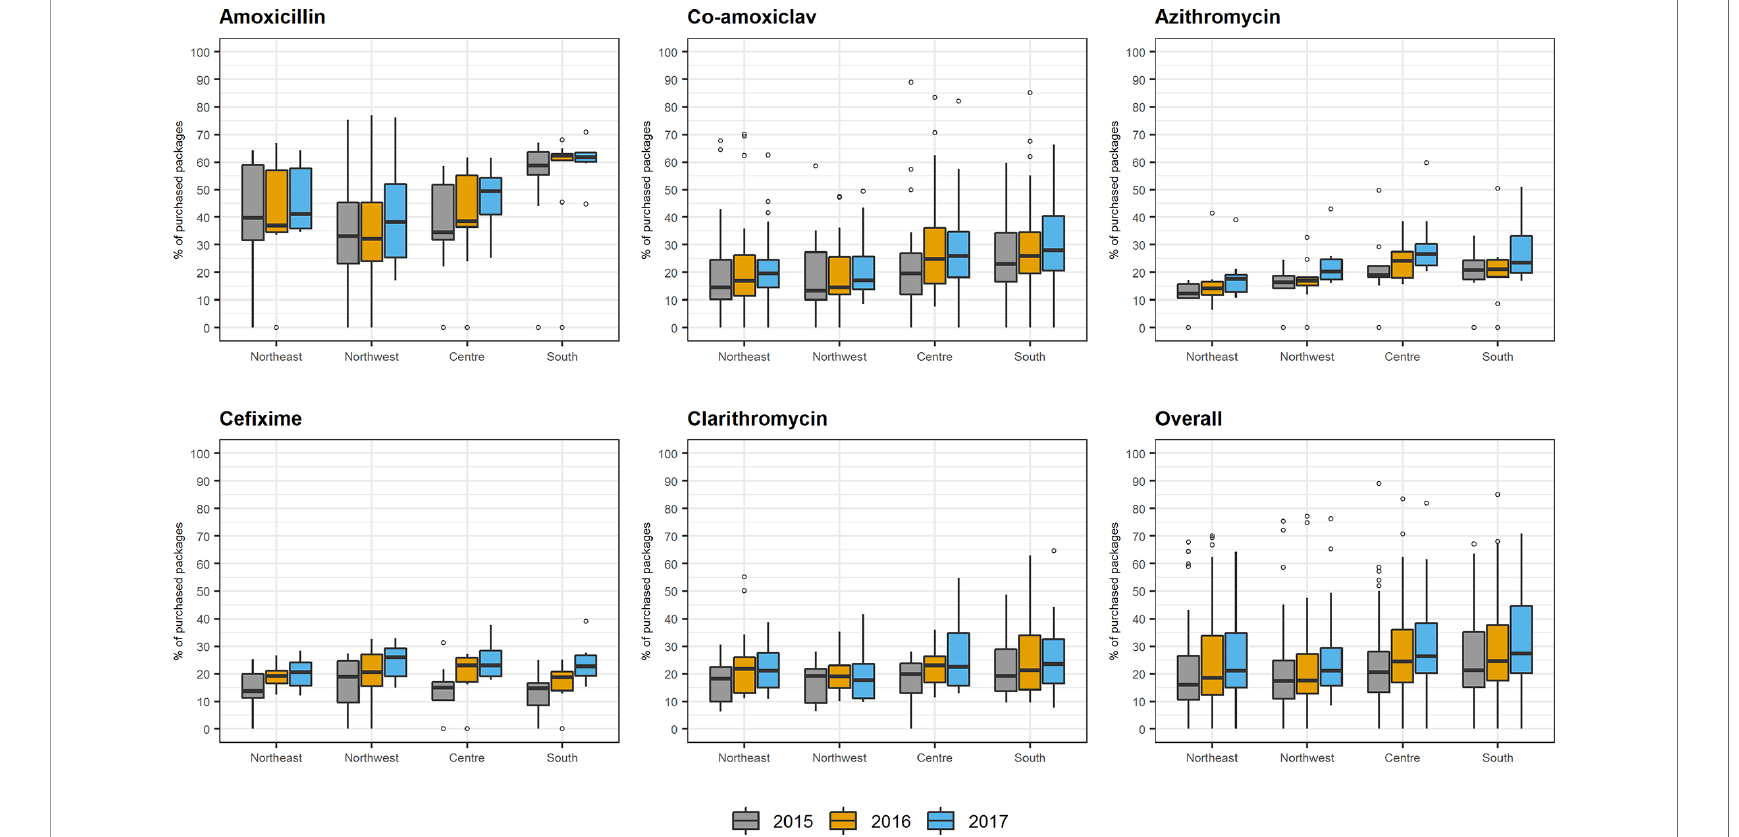
FIGURE 3 | Box plots of percentage of packages distribution purchased without a prescription for the top fi ve antibiotics used in children by geographic area and by calendar